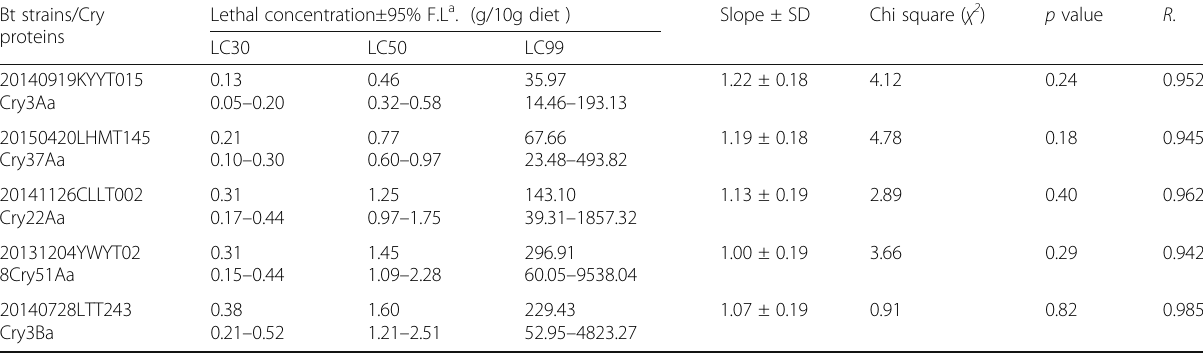
Table 2 Lethal and sublethal concentrations of various Cry proteins against third instar larvae of Tribolium castaneum 7 days post treatment Bt strains/Cry